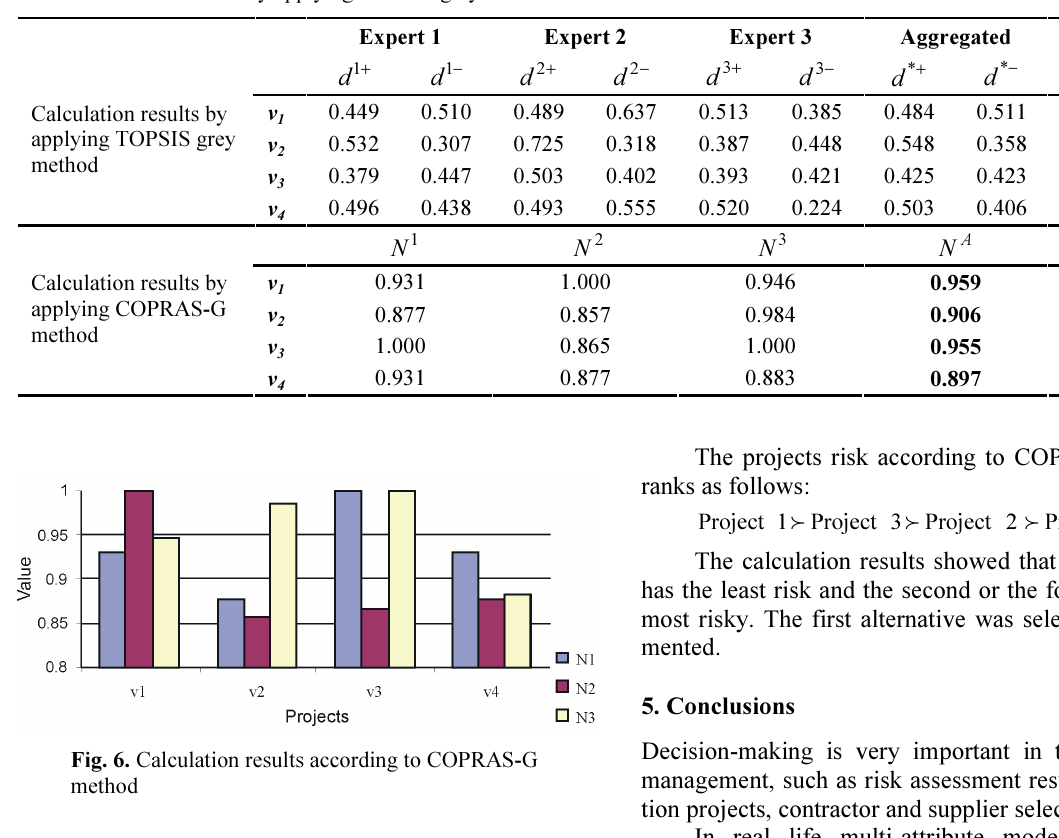
Table 3. Solution results by applying TOPSIS grey and COPRAS-G methods